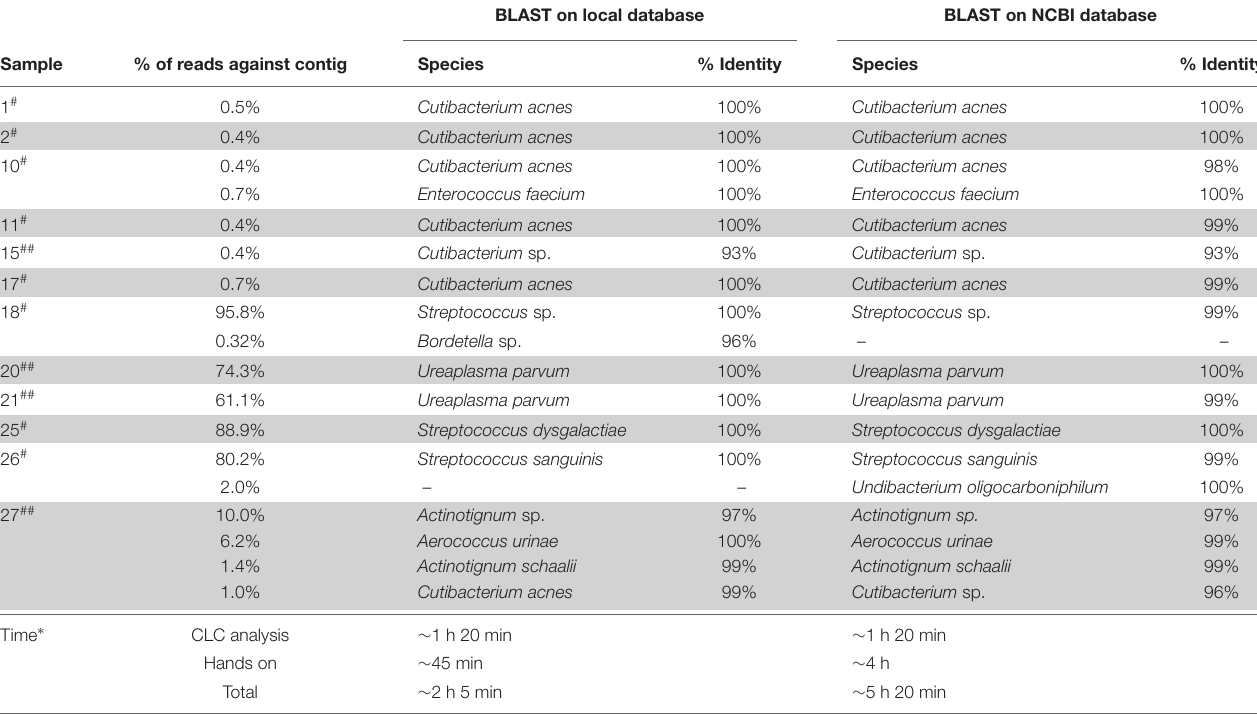
TABLE 1 | Comparison of BLAST analysis results for NGS positive samples using the local database and the NCBI